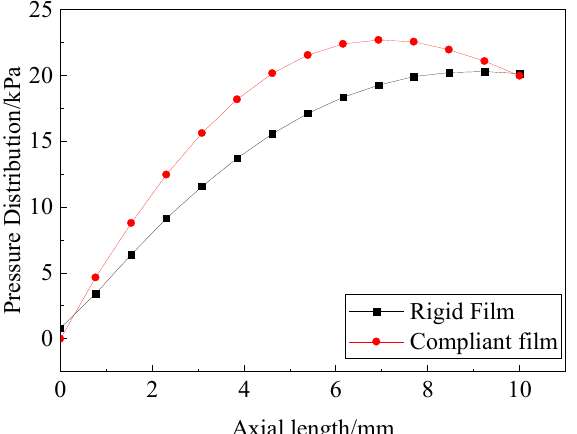
Figure 3. The effect of compliant structure on pressure distribution of the axial direction.